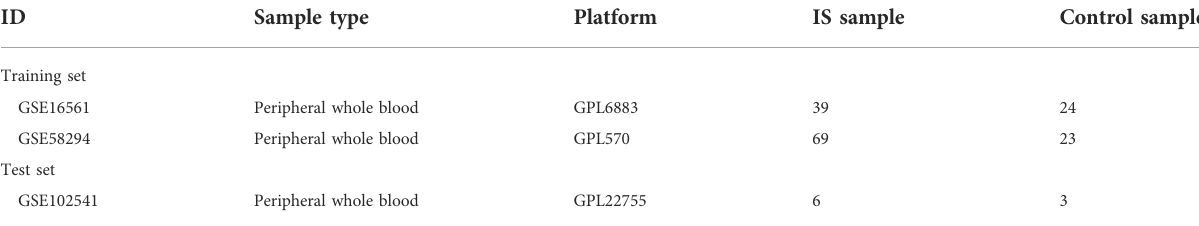
TABLE 1 Information of GEO